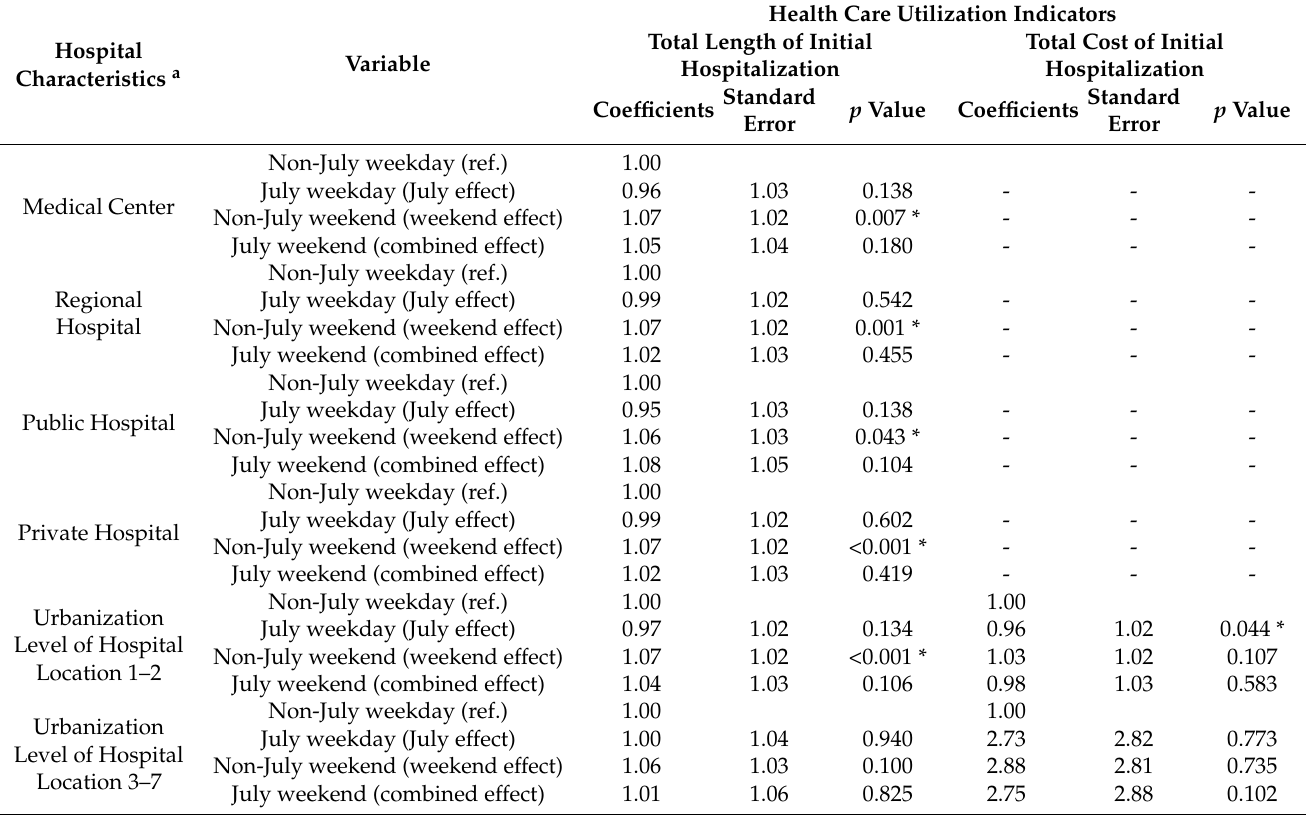
Table 5. Stratified analysis: multiple regression analyses with GEE models for influence of different admission times on health care utilization indicators in patients with stroke receiving treatments at hospitals with different